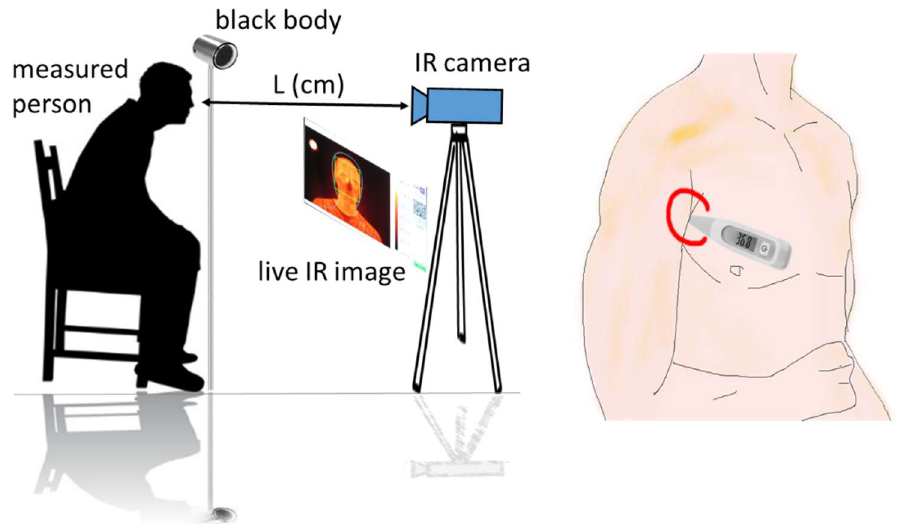
Figure 1. Scheme of the human temperature measurement by infrared thermography and by an armpit thermometer.